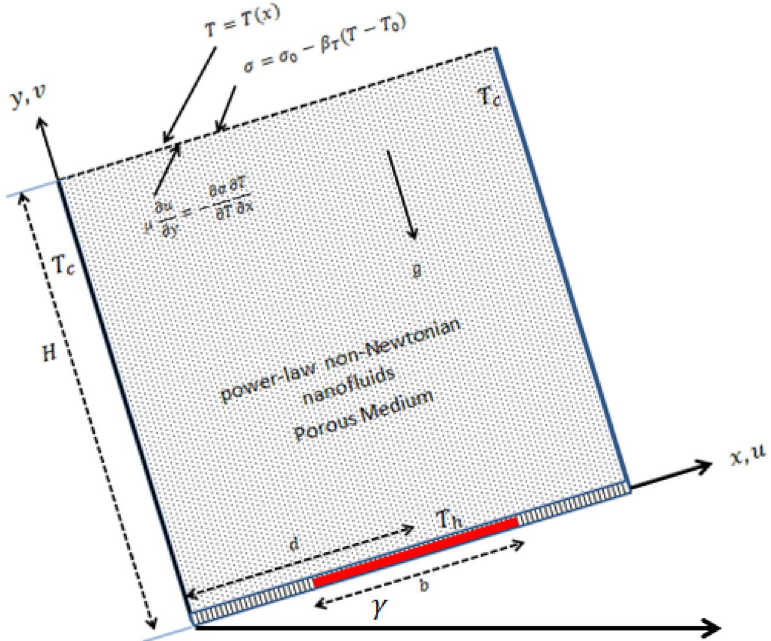
Figure 1. Physical model of the